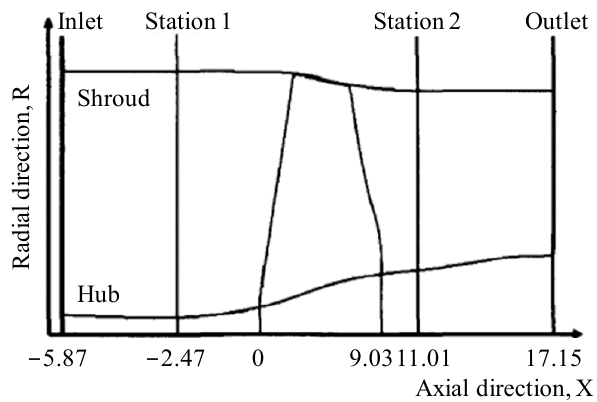
Figure 1. Geometric design of NASA rotor 67.